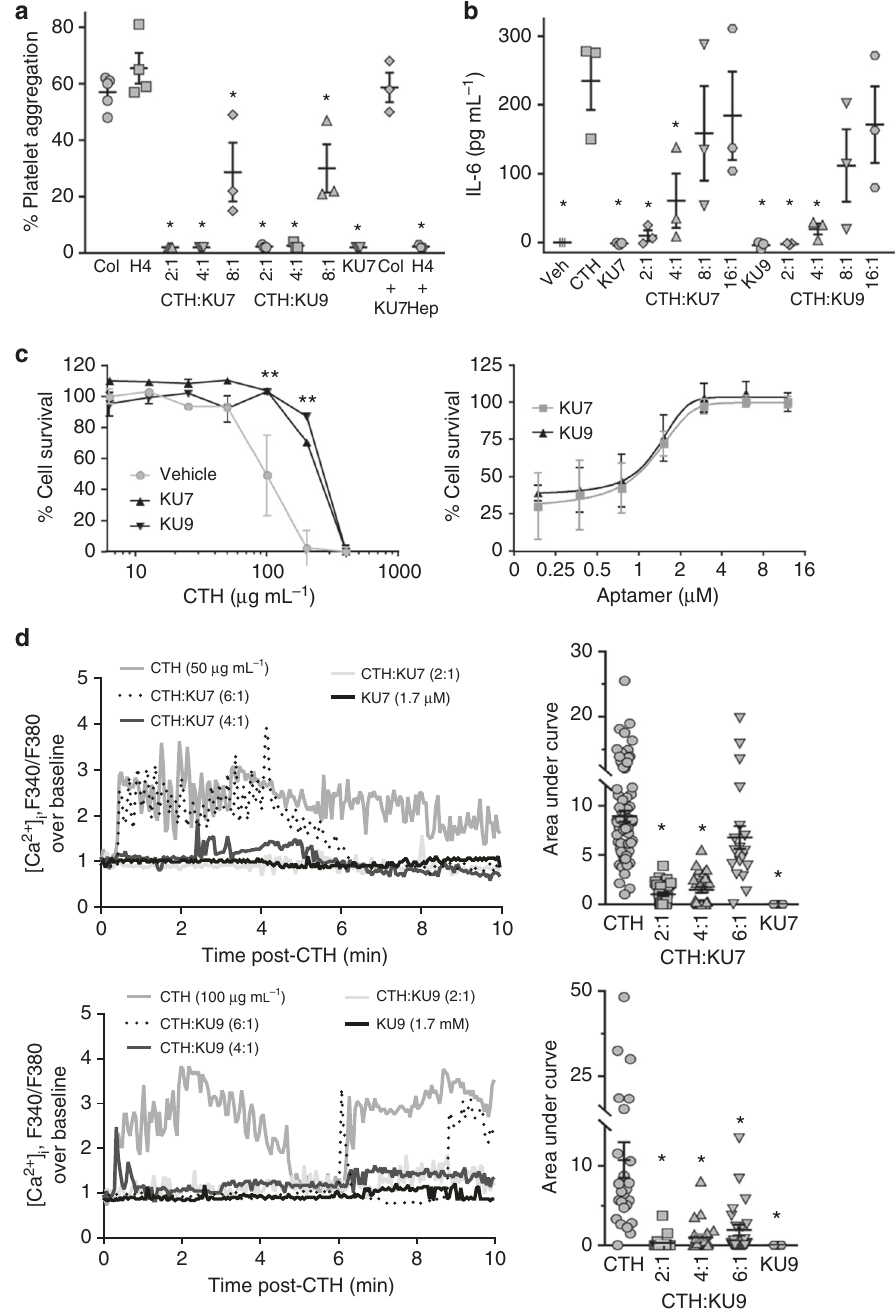
Fig. 3 In vitro ef fi cacy of RNA aptamers. a Human platelet aggregation measurements using platelets derived from three independent healthy donors. Collagen (Col), histone H4 (H4), histone aptamers (KU7 and KU9), calf thymus histones (CTH), heparin (Hep); * p < 0.01 vs. H4, one-way ANOVA corrected for multiple comparisons (Dunnett testing), n = 3 – 5. b TLR activation: IL-6 ELISA detection of IL-6 protein levels (as a measurement of TLR activation) in supernatants of EA.Hy926 cells treated with media alone (Veh), calf thymus histones (CTH), histone aptamers (KU7 and KU9) alone or in combination; * p < 0.01 vs. CTH, one-way ANOVA corrected for multiple comparisons (Dunnett testing), n = 3. c Cytotoxicity measurements: aptamer inhibition of histone-mediated cytotoxicity of endothelial cells determined by MTS assay. (Left panel) EA.hy926 cells treated with 1.2 µ M of aptamers (KU7 or KU9) and varying amounts (0 to 1000 µ g mL − 1 ) of calf thymus histones (CTH). (Right panel) EA.hy926 cells treated with 180 µ g mL − 1 of CTH and increasing amounts (0 to 16 µ M) of aptamers (KU7 or KU9); ** p < 0.01 vs. vehicle (100 µ g mL − 1 ), n = 4. d Dynamic changes of intracellular calcium levels in Fura 2-AM-loaded EA.hy926 cells using fl uorescence microscopy. (Left panel) Representative intracellular calcium elevation traces (F340/F380) of EA. hy926 treated with CTH alone, aptamer KU7 alone (25 µ g mL − 1 , top panels), aptamer KU9 alone (25 µ g mL − 1 , bottom panels) or in the presence of varying aptamer amounts (Molar ratio of CTH to aptamer indicated). (Right panel) Summary of data from multiple EA.hy926 cells ( n = 19 – 69 cells per bar); ** p < 0.01 vs. CTH, one-way ANOVA corrected for multiple comparisons (Tukey's testing), n = 3. Data represent mean ±